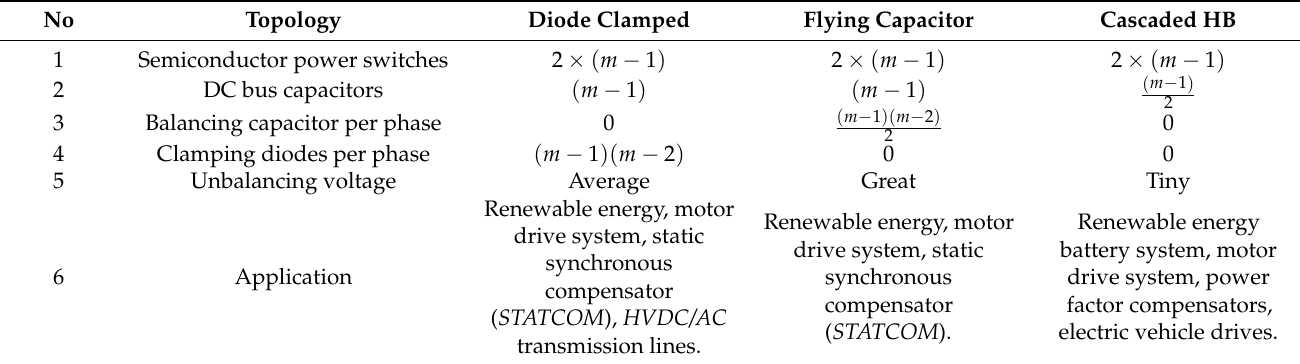
Table 3. Comparison of multilevel inverters based on the number of components